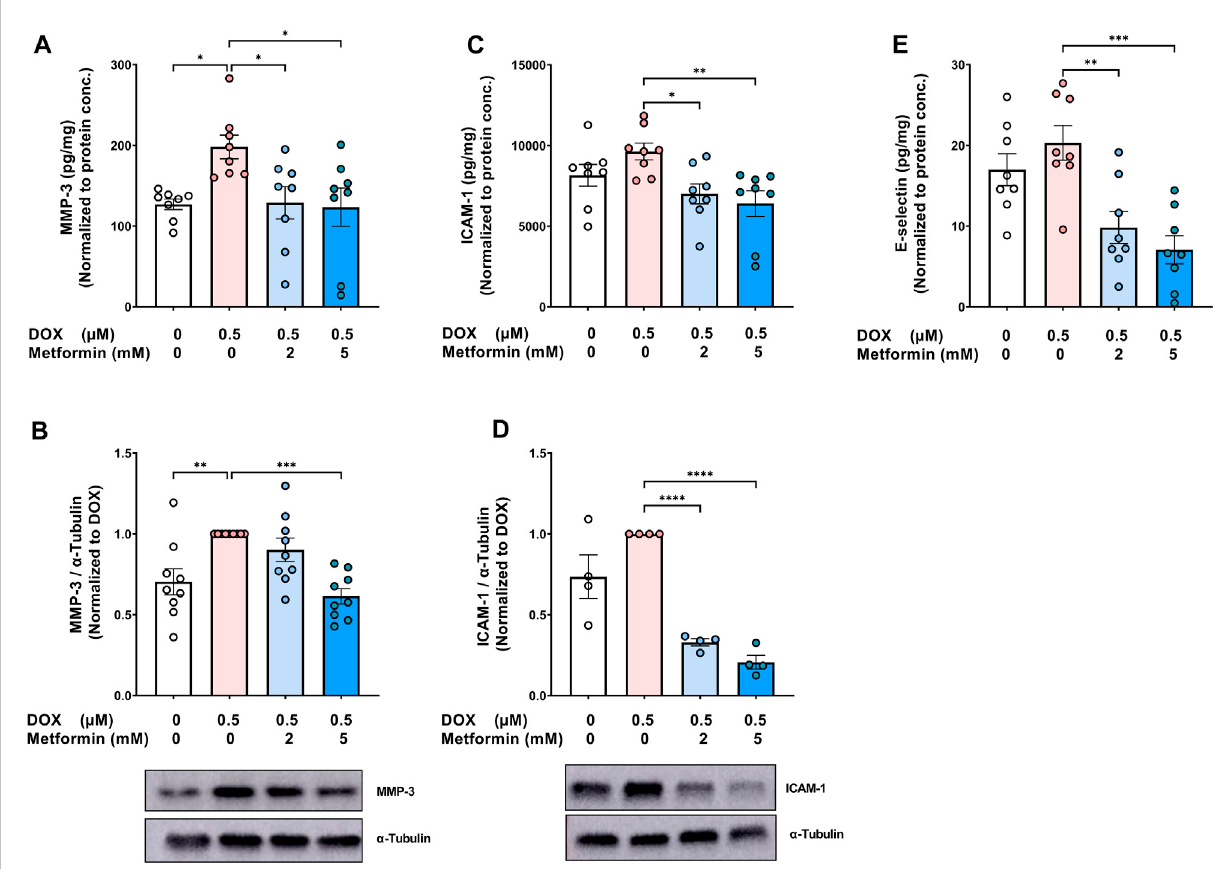
FIGURE 3 Metformin decreased the protein expression of SASP protease, MMP-3, and endothelial adhesion molecules in HUVECs. HUVECs were treated for 24 h with 0.5 µM DOX ± metformin (2 and 5 mM, added 24 h before DOX). Thereafter, DOX was removed and the cells were incubated in DOX-free media with or without metformin for an additional 72 h. The protein expression of the SASP protease MMP-3 was determined in (A) culture media by Luminex and (B) cell lysate by western blotting (n = 8 – 9). Expression of the endothelial adhesion molecules ICAM-1 in (C) culture media (n = 8) and (D) celllysate(n=4),and (E) E-selectin(n=8)intheculturemediaweredetermined.Representativeimagesofwesternblotsareshown.Expressionvalues in the media were normalized to the protein concentration of the cells determined by BCA. Values are shown as means ± SEM. Data were analyzed by one-way ANOVA followed by a Dunnet ’ s multiple comparisons test (Figures 3A,B,D – E) or non-parametric Kruskal – Wallis tests followed by Dunn ’ s post hoc test (Figure 3C); * p < 0.05, ** p < 0.01, *** p < 0.001, **** p <